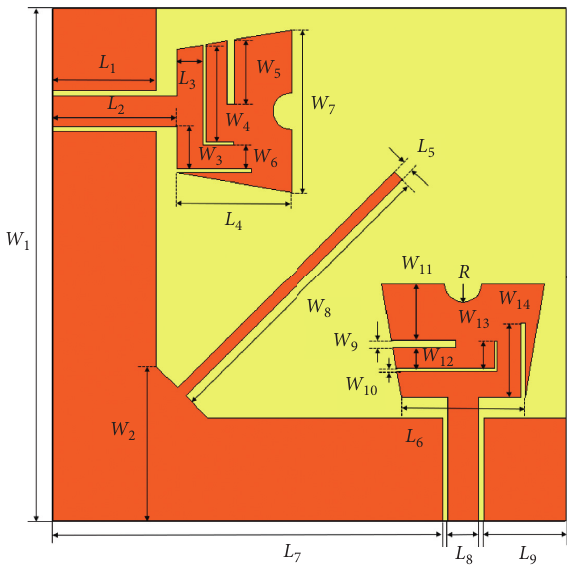
Figure 1: Geometry of the proposed antenna.